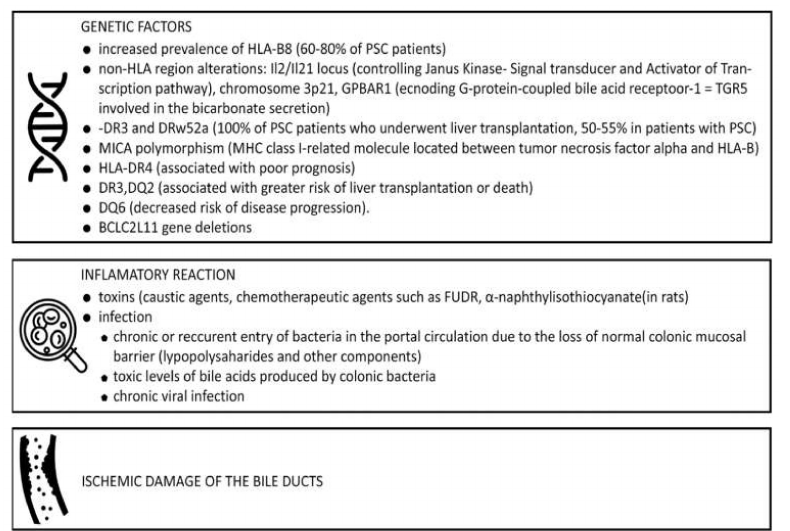
Figure 1. Factors involved in etiopathogenesis of Primary sclerosing cholangitis (PSC)